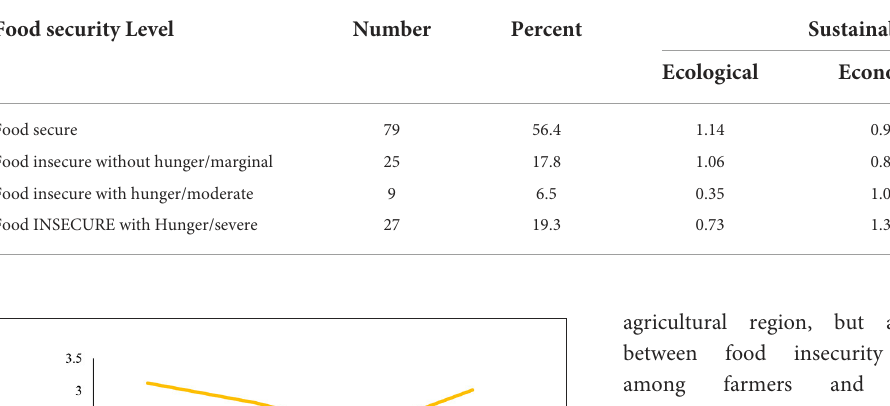
TABLE 7 The status of household’s food security and agricultural sustainable dimensions in the study location.